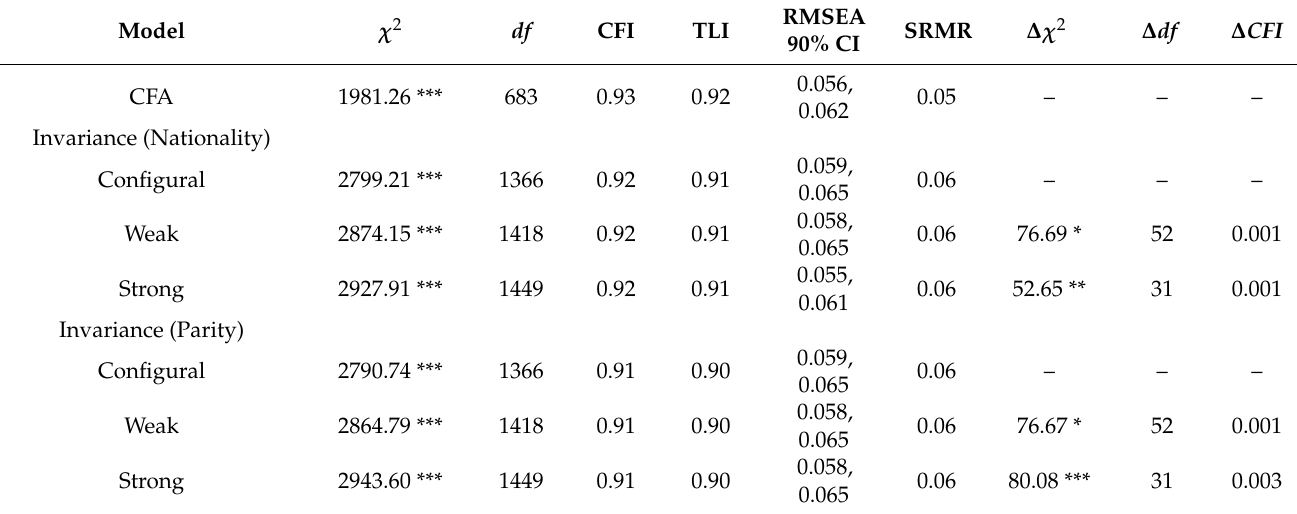
Table 8. Model fit indexes for CFA model and invariance between nationality (Canada vs. USA) and parity (primiparous vs. multiparous)